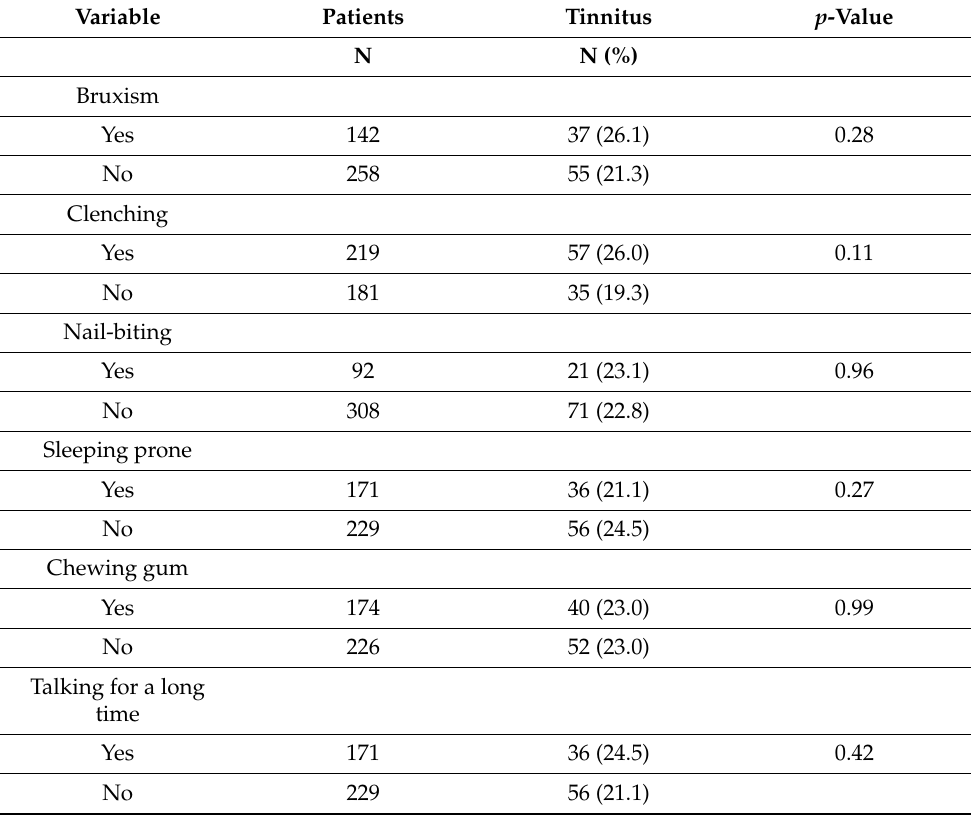
Table 1. Prevalence of tinnitus according to selected parafunctional habits in patients with temporo- mandibular disorders.